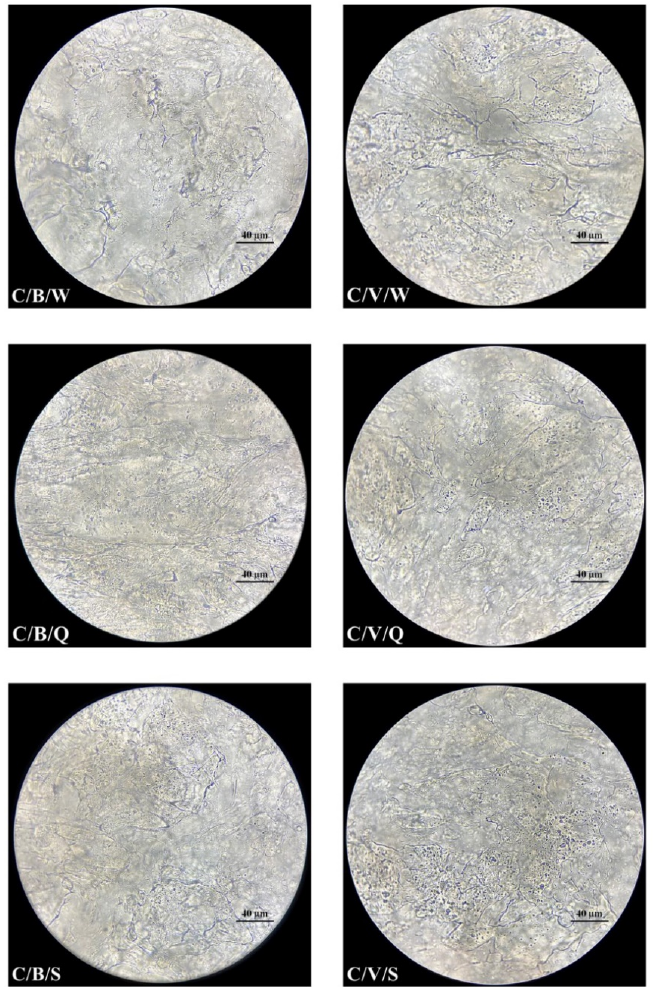
Figure 1. Microstructures of pasta filata cheeses from cow’s milk (optical microscopy, 1000 × objective); Milk (used in cheese production): C: cow’s milk; Packaging (method): B: Packed with brine; V: Vacuum packed; Fragmentation (method): W: Whole sphere; Q: Quarters; S: Slices.